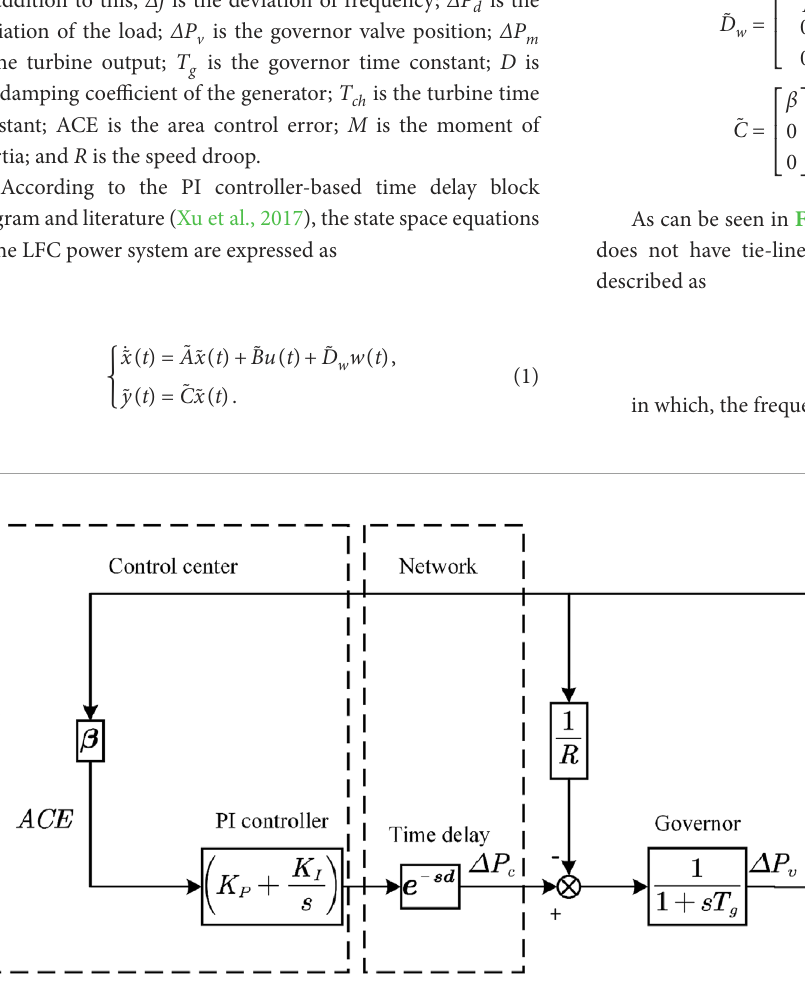
FIGURE 1 Basic diagram of the simplified one-area LFC power